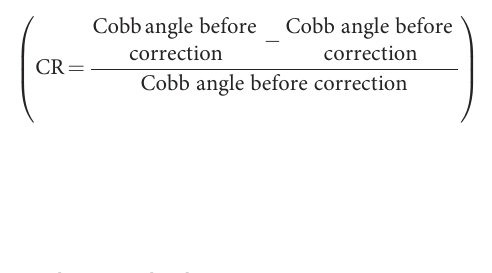
All patients underwent intraoperative skull bone traction. Motor-evoked potential and somatosensory-evoked potential monitoring were used during the operation of 28 (60.9%) patients.